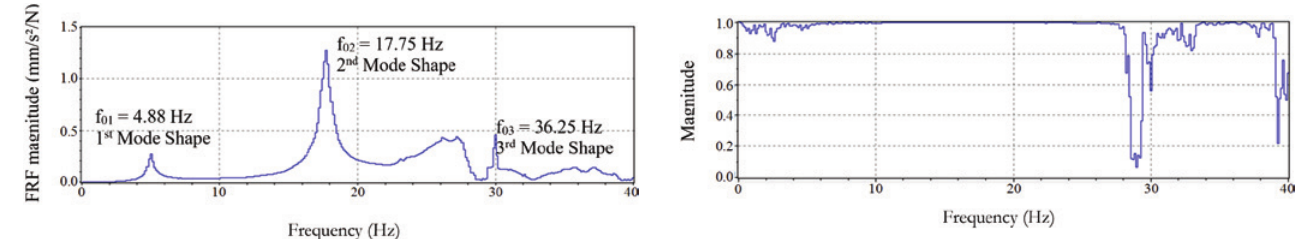
(e) Point 3 (3/4 of the span): FRF Figure 8 Experimental FRF magnitudes and consistency curves of the footbridge vibration modes (Test 2)